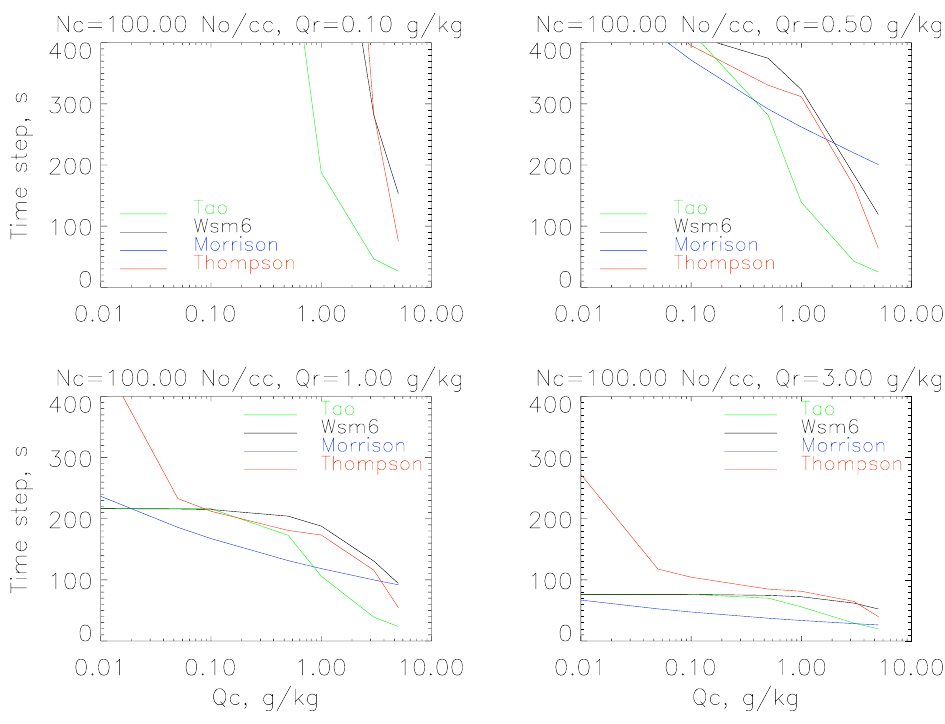
Fig. 3. Maximal time step dependence on Q c and Q r for N c = 100 cm − 3 .